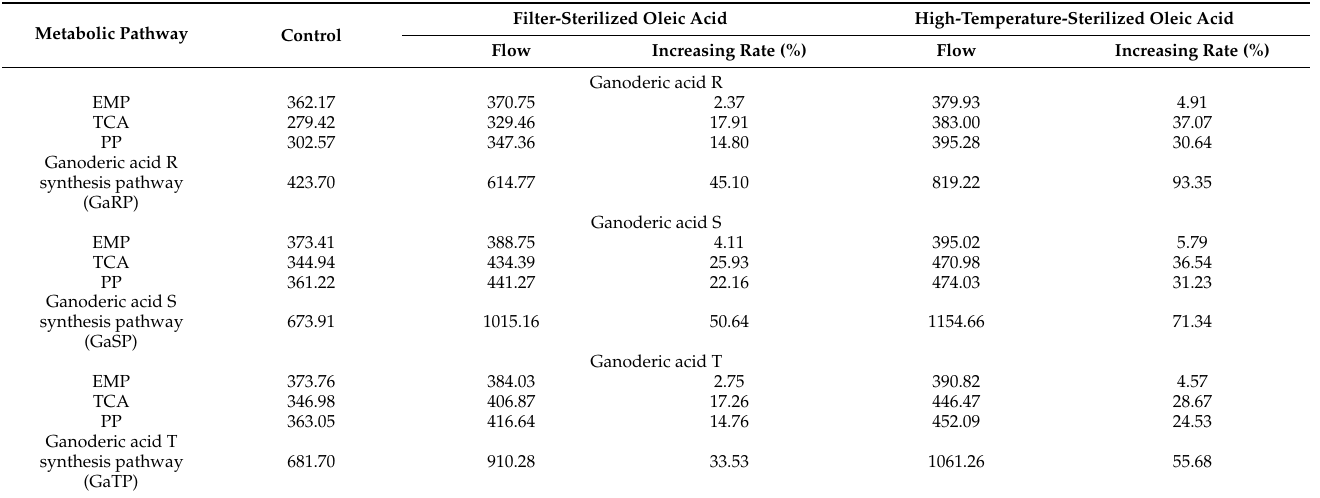
Table 2. Statistics of metabolic pathway flow direction of ganoderic acids R, S and T, synthesized by submerged fermentation-static culture under two methods of oleic acid